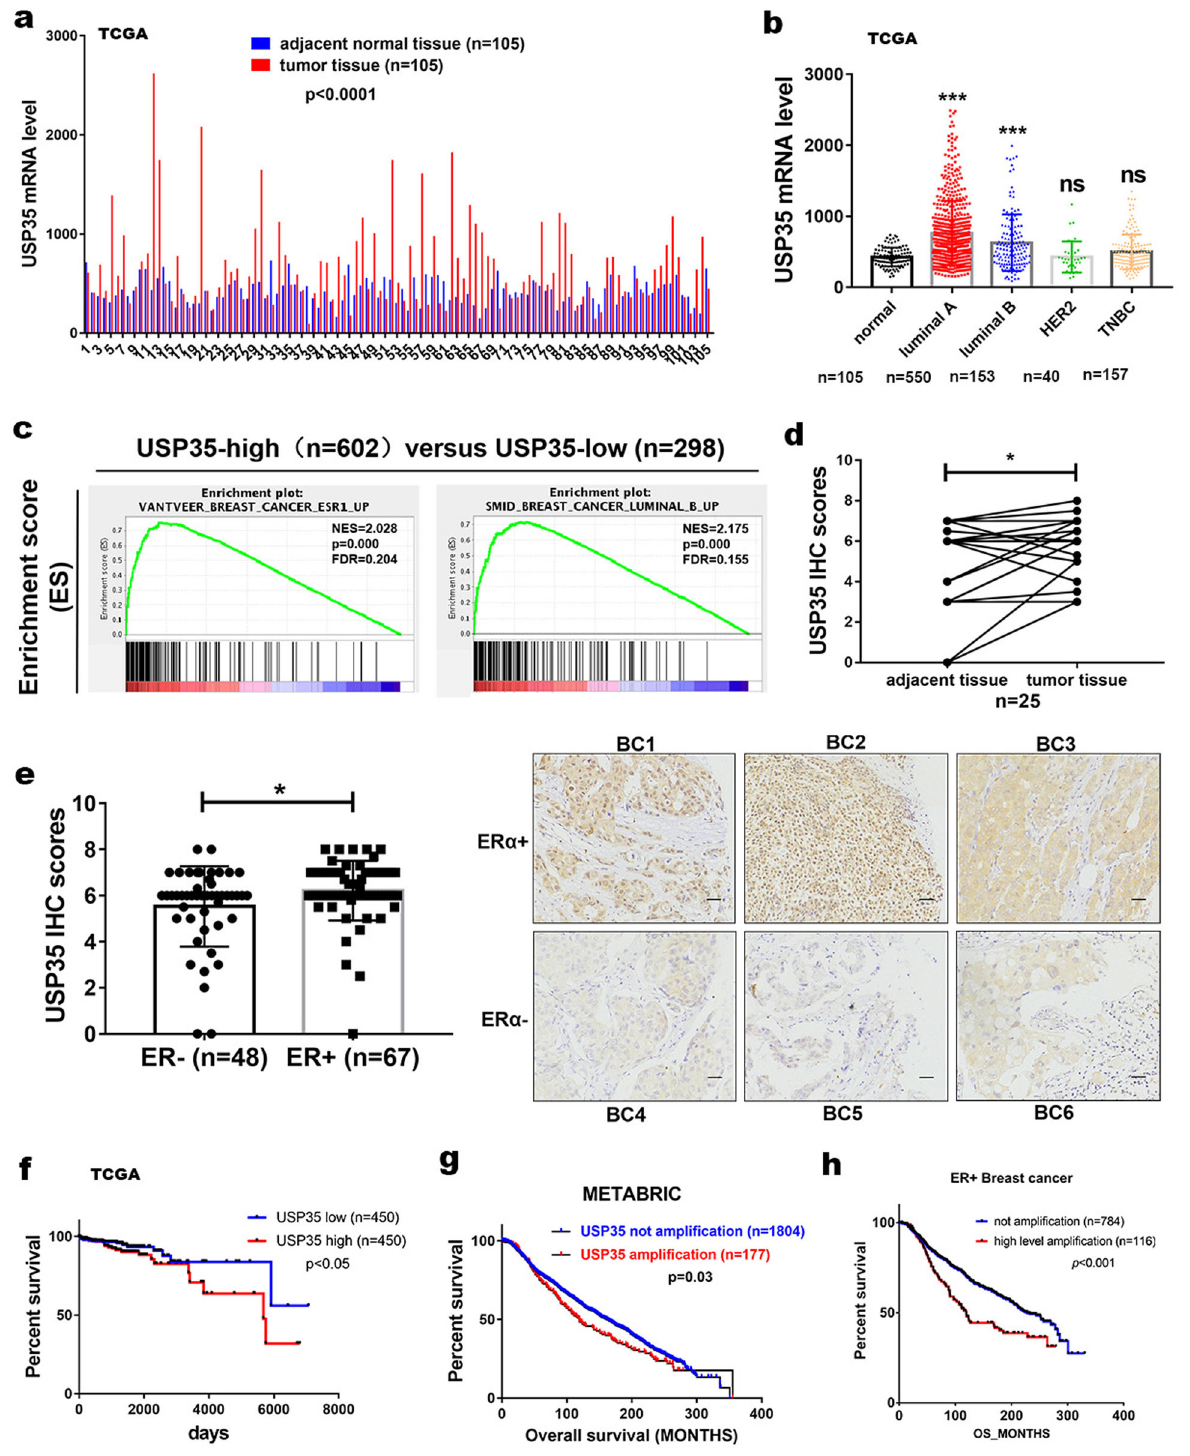
Fig. 1 Higher USP35 expression is associated with ER + breast cancer and predicts poor outcome. a USP35 mRNA levels in tumor tissues are signi fi cantly higher than in normal tissues. p < 0.0001, two-tailed paired Student ’ s t -test. b USP35 mRNA level is higher in luminal than in other subtypes of breast cancer. **, p < 0.01; ***, p < 0.001; ns not signi fi cant, one-way ANOVA. c Gene Enrichment Set Analysis (GESA) showed that breast cancer with high USP35 mRNA level was enriched with the ESR1 up, luminal B up sets. d USP35 immunohistochemistry analysis showed that USP35 protein levels were higher in primary breast tumor tissues than in paired adjacent normal tissues. e Immunohistochemistry analysis showed that USP35 protein levels were signi fi cantly higher in ER + than in ER − breast tumors (left). *, p < 0.05, two-tailed Student ’ s t -test. USP35 staining in different ER + and ER − breast tumors were shown (right). Scale bar, 100 μ m. Kaplan – Meier analysis for overall survival of breast cancer patients depending on USP35 mRNA levels in the TCGA database ( f ), USP35 ampli fi cation status in breast cancer ( g ), and in ER + breast cancer ( h ) in the METABRIC database were shown. p value was calculated using the log-rank test.